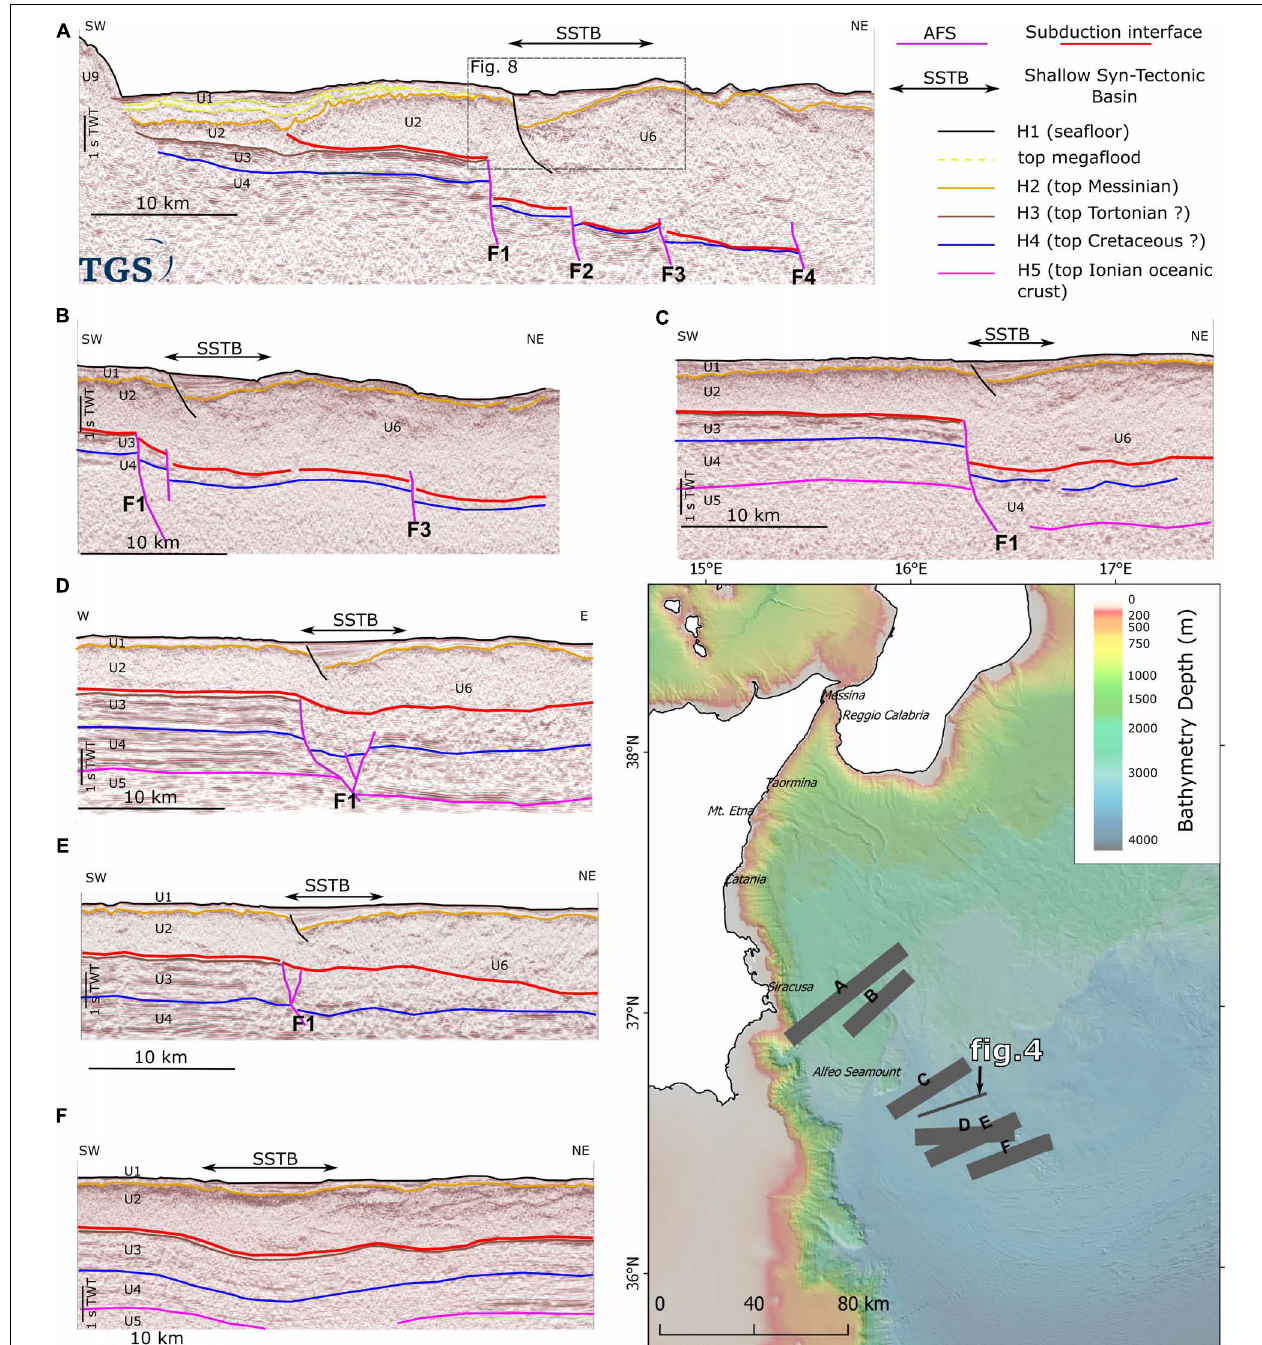
FIGURE 5 | Progressive structural changes of the AFS from north to south (see inset map for locating the Sections (A–F) . The labels F1–F4 identify the major fault segments of the AFS. The data presented here are subject to a confidentiality agreement with TGS that does not allow us to show the absolute two-way-time on the seismic profiles. The blank version of the sections is available in the Supplementary Figure 2